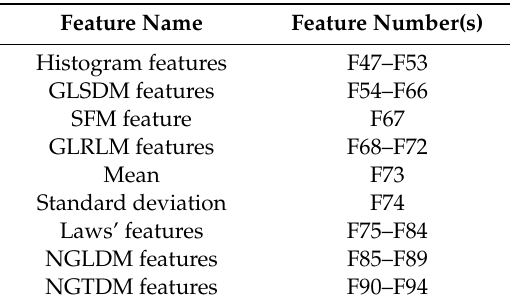
Table 9. Wavelet transform feature sets.